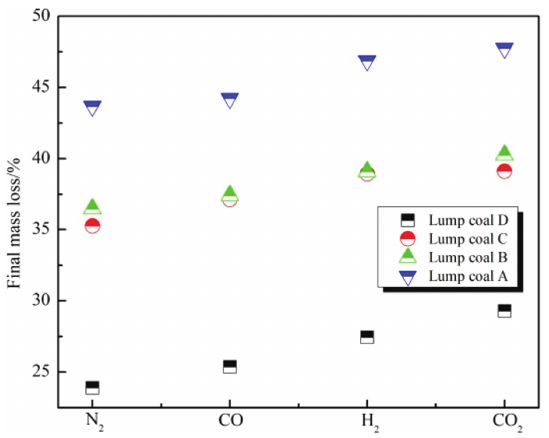
Figure 8: Final mass loss of lump coals under different